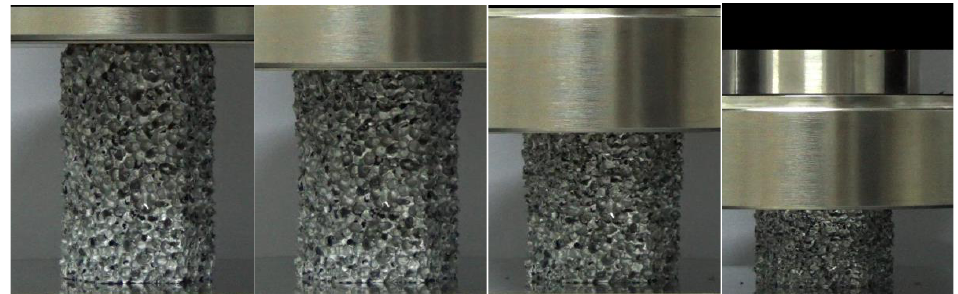
Figure 2. Deformation modes of hexagonal foam under quasi-static compression test.